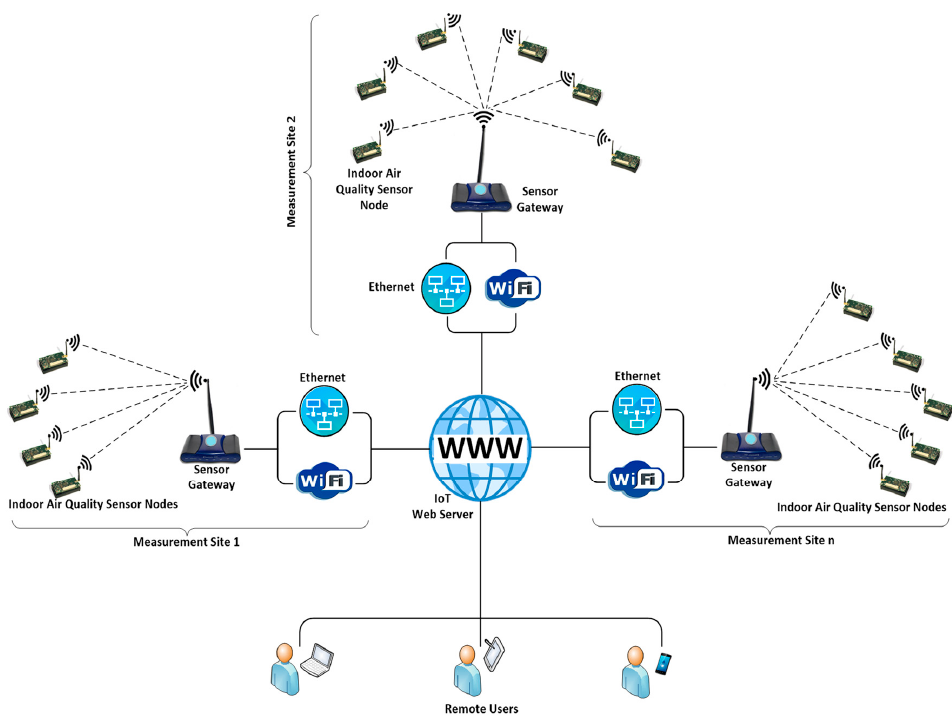
Figure 1. IAQM system architecture.